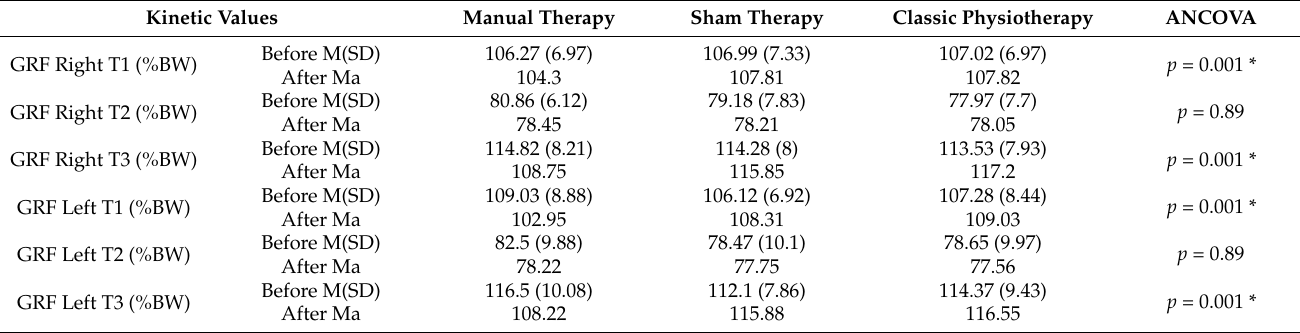
Table A1. ANCOVA results on kinetic values.